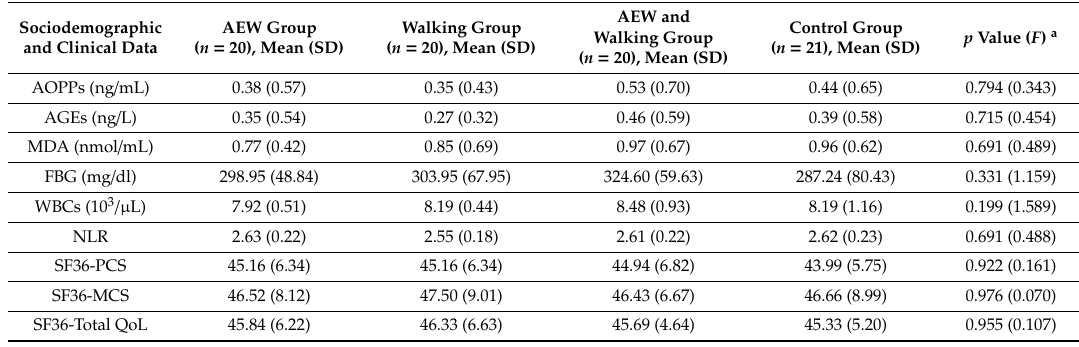
Table 2. Baseline values of participants’ oxidative stress, inflammatory biomarkers and quality of life among the four groups ( n =